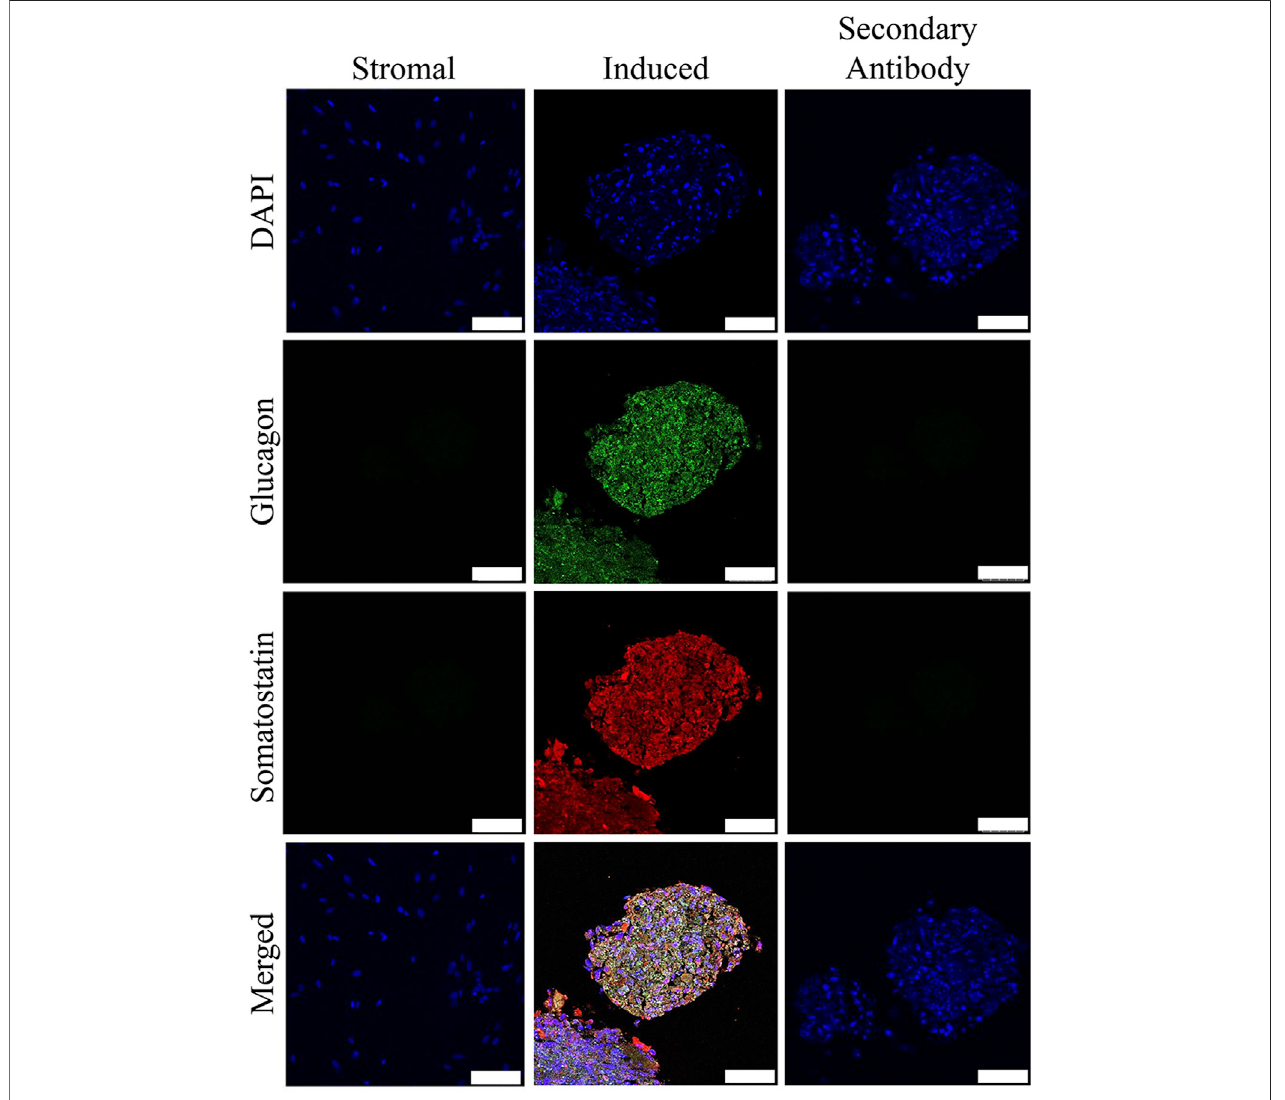
FIGURE5| Fluorescent photomicrographsofcellclustersafterculture instromalmedium (Stromal)orthreestages ofpancreatic induction medium (Induced) from pooled male and female feline ASCs labeled with DAPI (blue), somatostatin (red) and glucagon (green). Clusters labeled with only the secondary antibody (Secondary Antibody) are also shown. Scale bars = 50